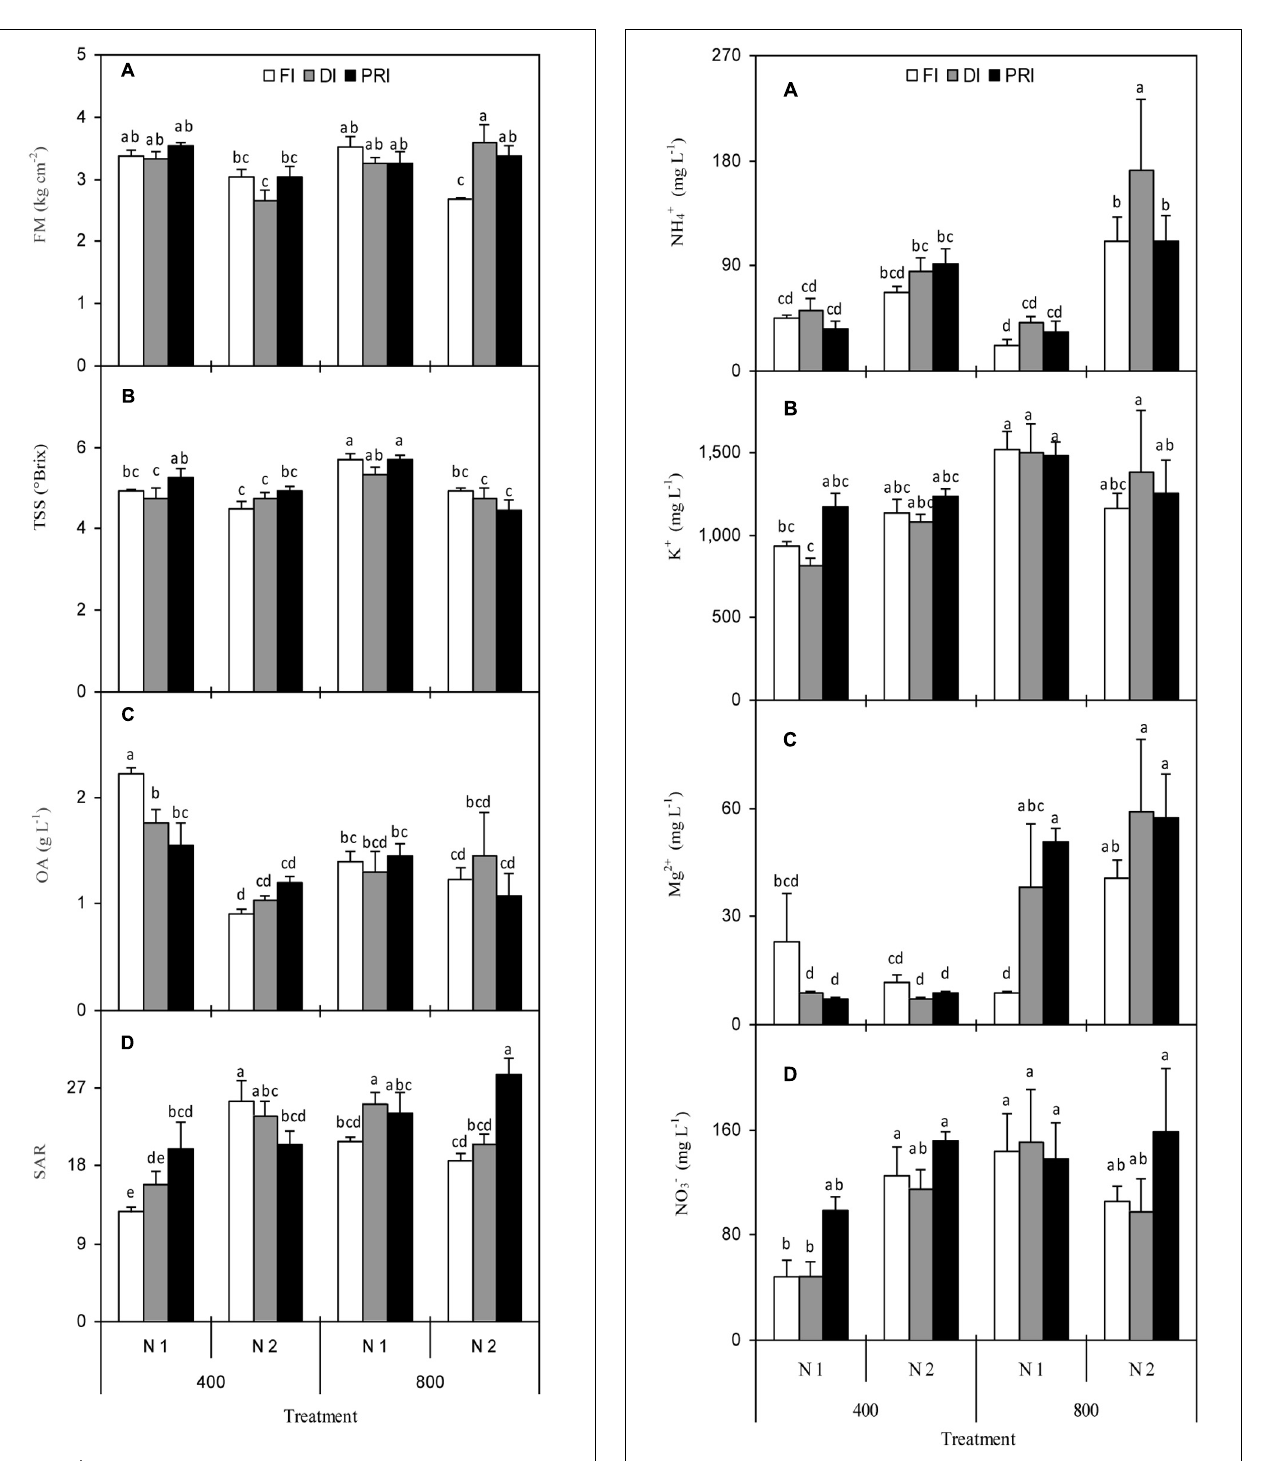
FIGURE 3 | NH 4 + (A) , K + (B) , Mg 2 + (C) , and NO 3 − (D) concentration in fruit juice of tomato plants as affected by the atmospheric [CO 2 ] (400 and 800 ppm), N fertilization rates (N1 and N2), and irrigation regimes (FI, DI, and alternative PRI). Error bars indicate standard error of the mean ( n = 4). Different letters at each sampling data indicate significant differences between treatments according to LSD’s multiple range test at P < 0.05. Statistical comparisons among the treatments are presented in Table 2